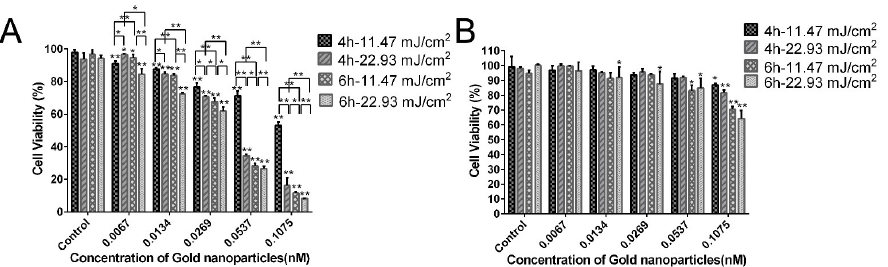
Figure 5. The anti-growth effect of PEG-AuS on SGC-7901 cells ( A ) and GES-1 cells ( B ) after treated with PEG-AuS with different conditions by CCK-8 assay. *: p < 0.05; **: p < 0.01. 3.5. Apoptosis and Necrosis Induced by PEG-AuS Irradiated by the Nanosecond Pulsed Laser Systems The significant antigrowth effect can be obtained at 6 h incubation time and 11.47 mJ/cm 2 irradiation dosage or at 4 h incubation time and 22.93 mJ/cm 2 irradiation dosage. Is there a difference in the method of cell death induced by them? Hence, the apoptosis and necrosis were further evaluated at 0.1075 nM, 0.0537 nM, 0.0269 nM, 0.0134 nM, 0.0067 nM by Hoechst 33324/PI nuclear staining kits. Cell shrinkage, nuclear fragmentation and so on as cell emblematic apoptotic characteristics can be observed with Hoechst 33,324 staining dye and cell plasma membrane unintegrated as cell representative necrosis char- acteristics can be stained with PI staining dye (PI cannot cross the membrane of live cells).